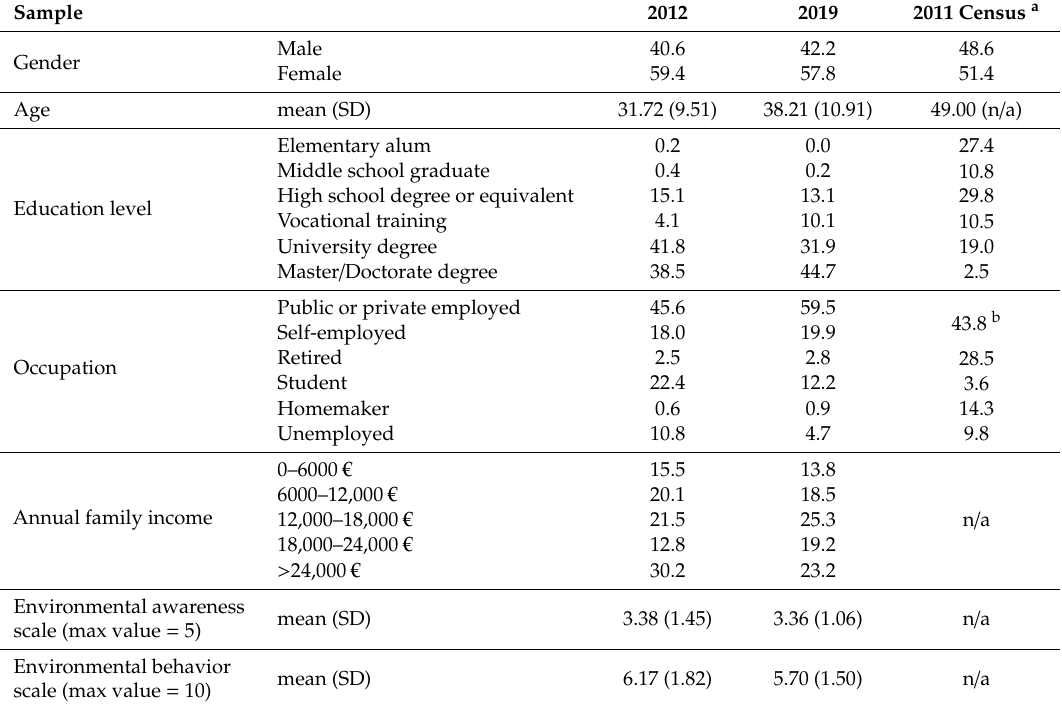
Table 1. Demographic and socio-economic